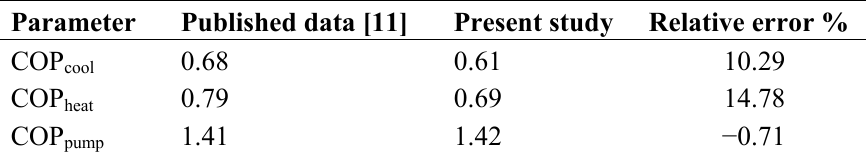
Table 3. Comparison of COP results.